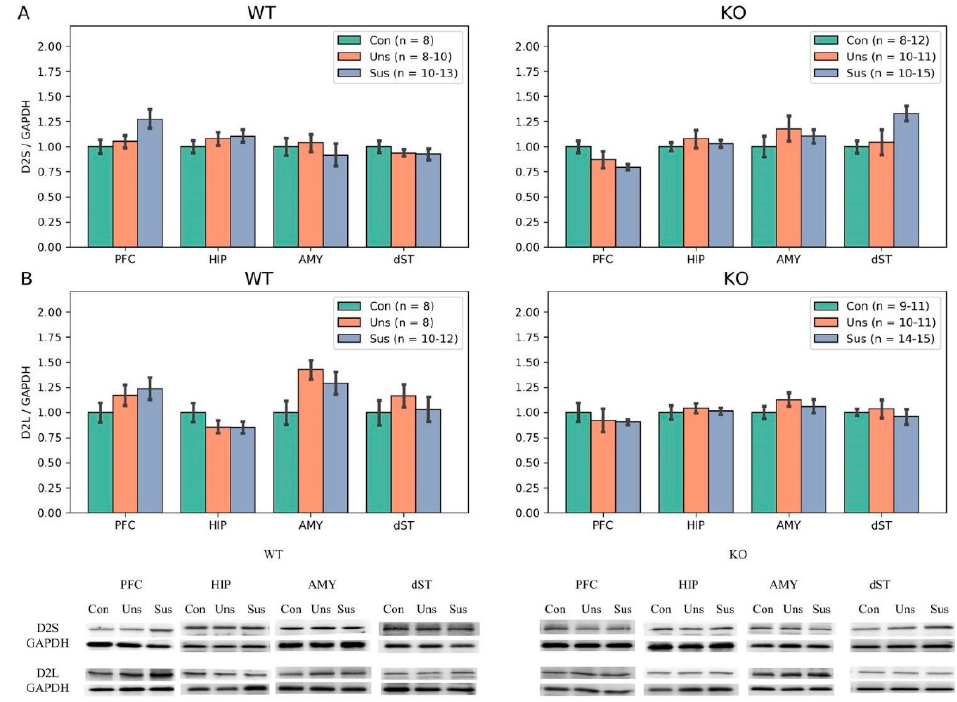
Figure 6. Western blot results of dopamine isoform among three groups in STMN WT and KO mice. ( A ) D2S: expression levels of total D2S in the PFC, HIP, AMY and dST; and ( B ) D2L: expression levels of total D2L in the PFC, HIP, AMY and dST. Con, Control; KO, Knock Out; Sus, Susceptible; Uns, Unsusceptible; WT, Wild-Type.